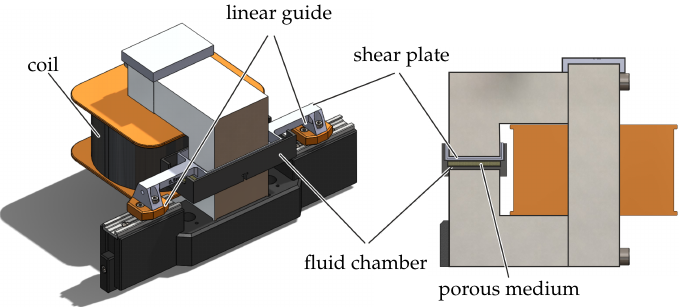
Figure 4. Design of the MR damper ( left ) and a cut section showing the magnetic circuit ( right